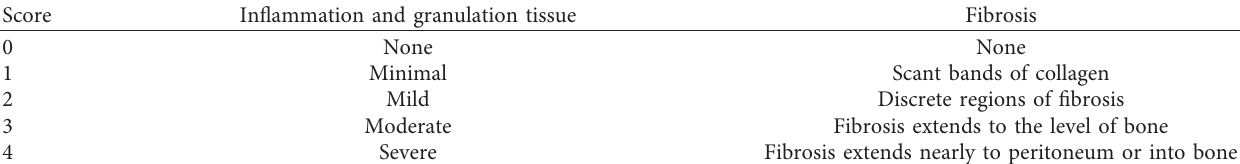
Table 1: System for histologic grading of dermal wounds in marine toads ( Rhinella marina